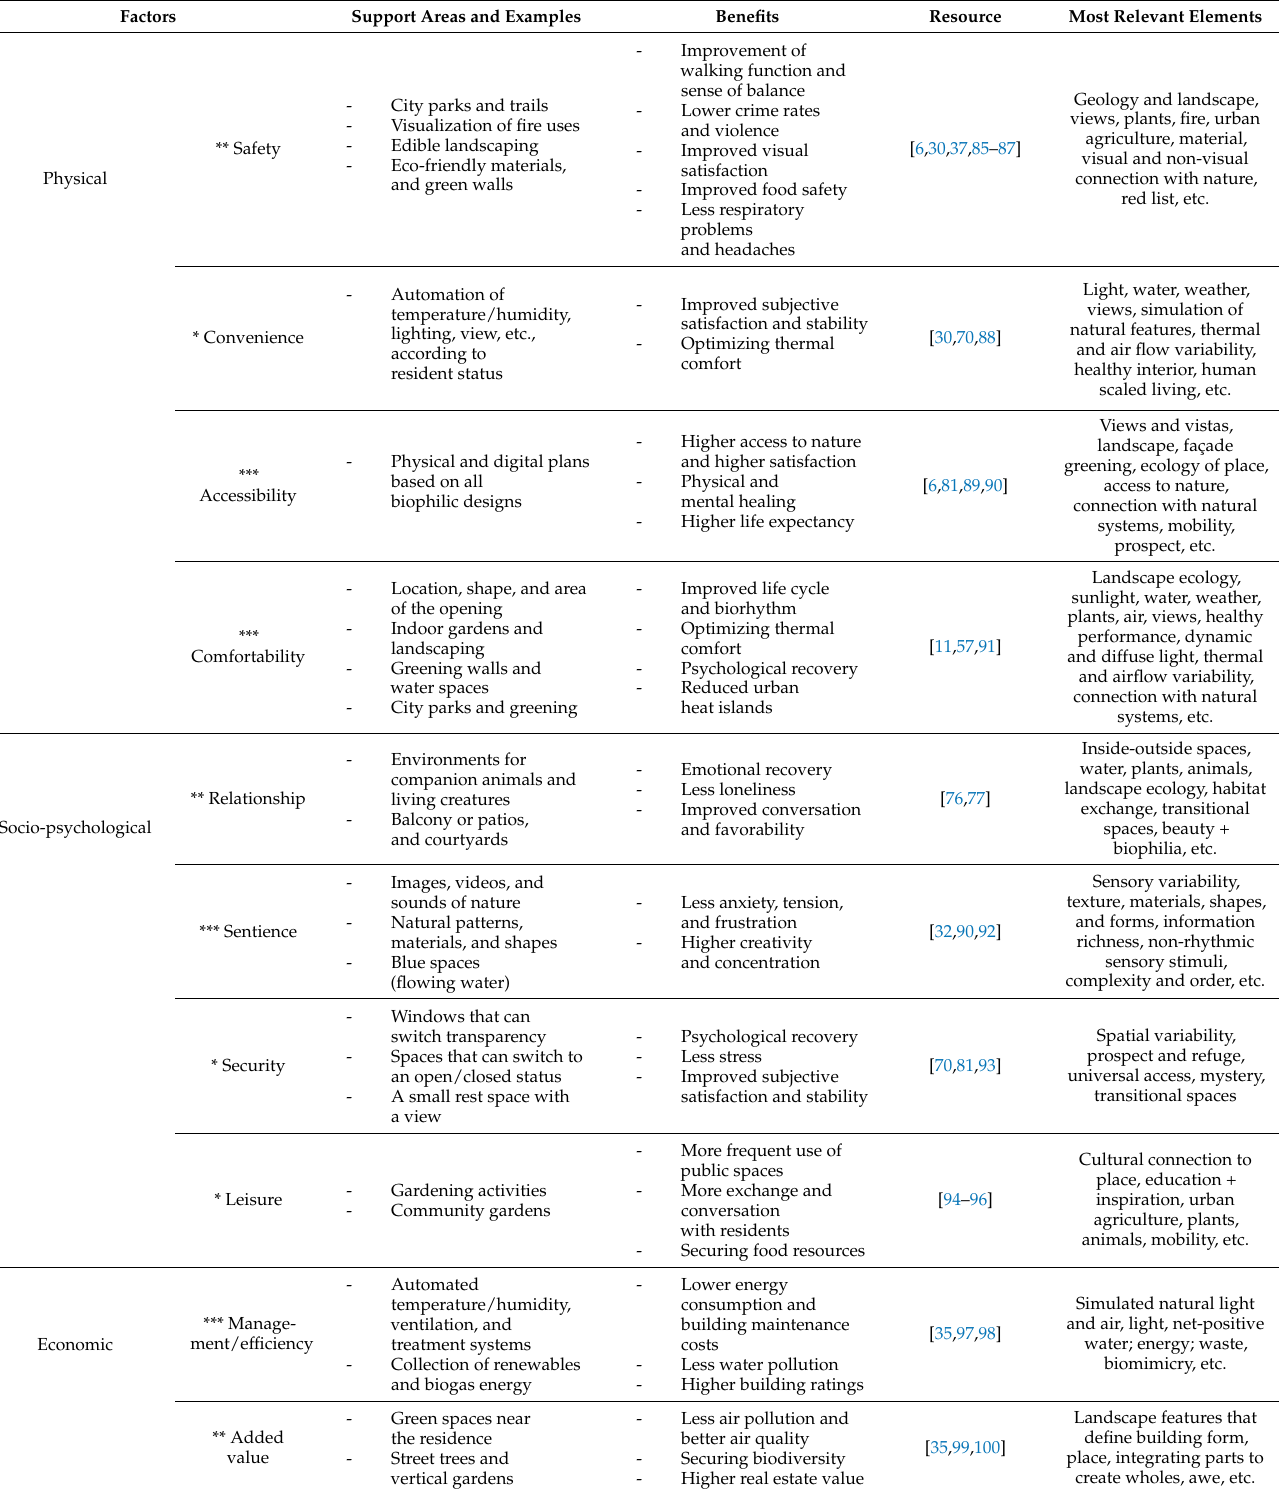
Table 3. Residential environment factors and supportability of biophilic